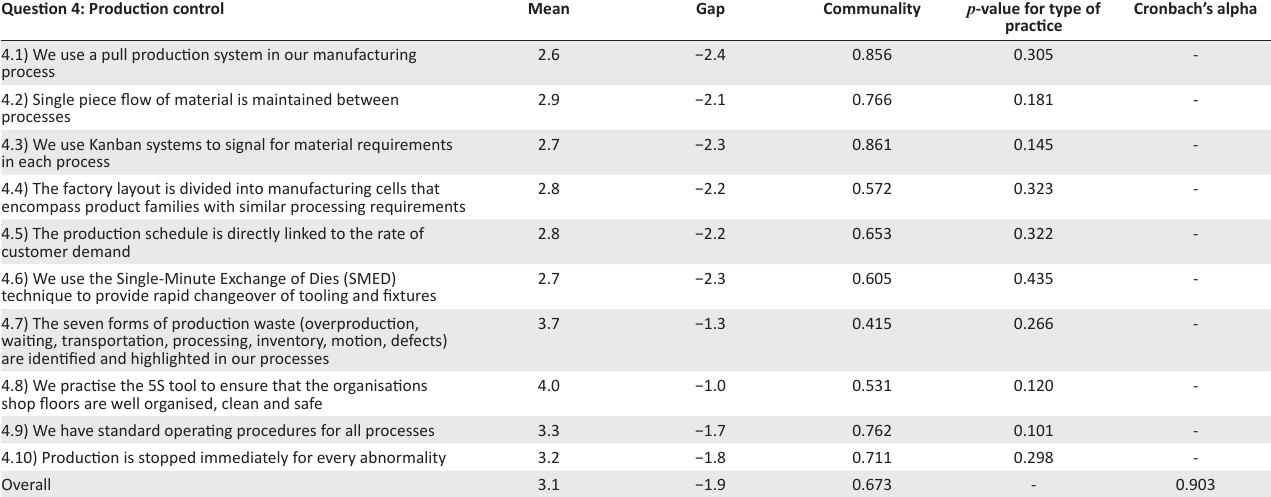
TABLE 5: Results pertaining to production control. Question 4: Production control